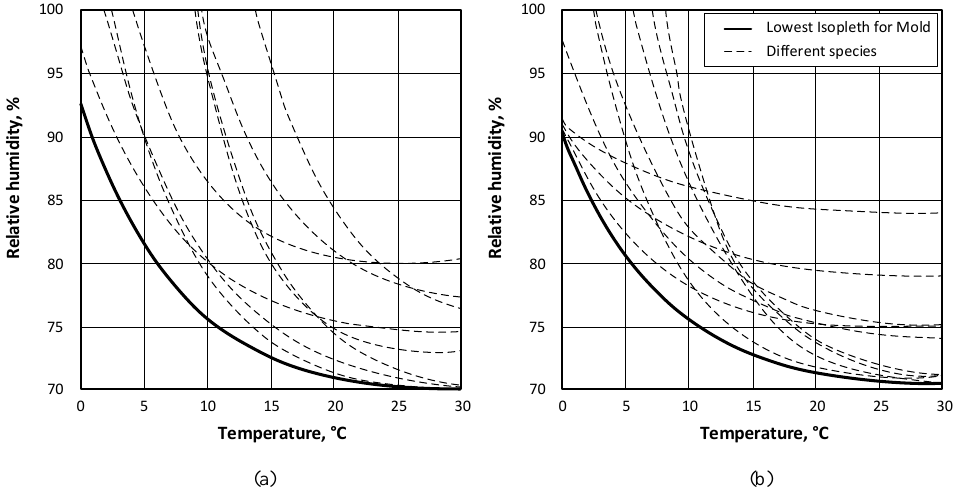
Fig. 6. The Lowest Isopleth for Mold of different species for spore germination (a) and mycelium growth (b) [29]. If the temperature is +10  C and there are enough nutrients and time, spore germination